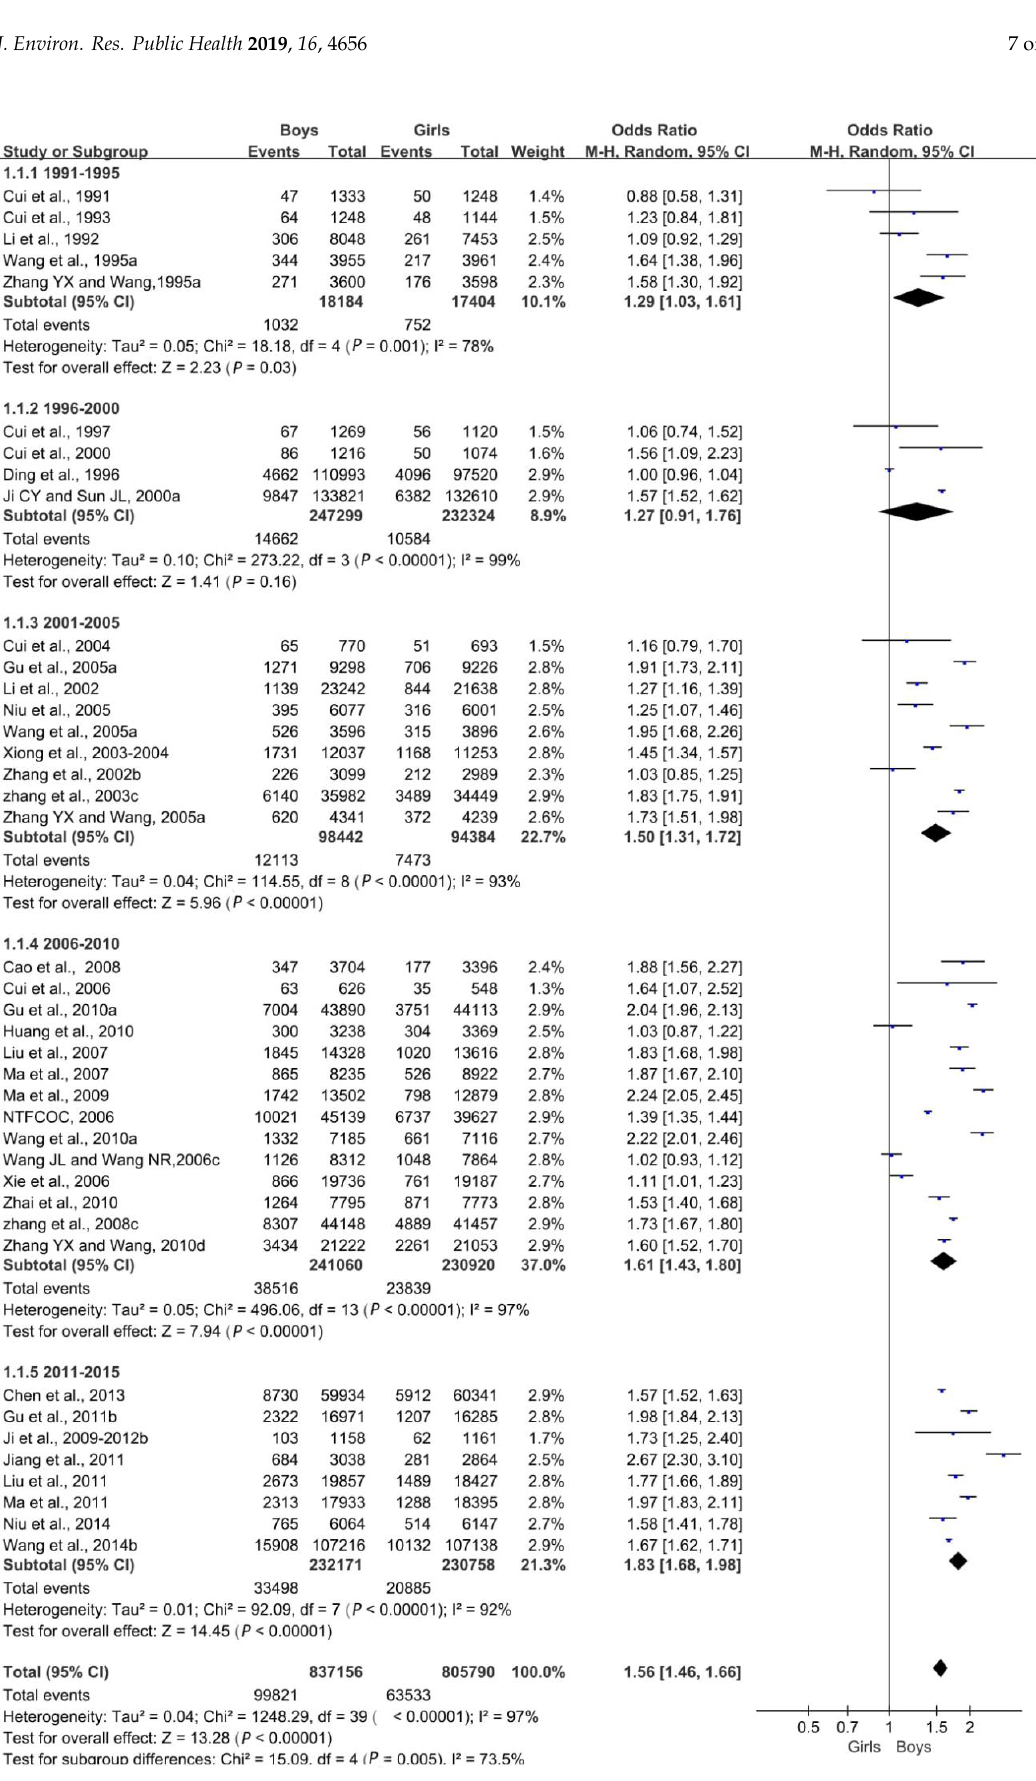
Figure 2. Forest plot of overweight in boys compared with girls aged 0–18 years in China.